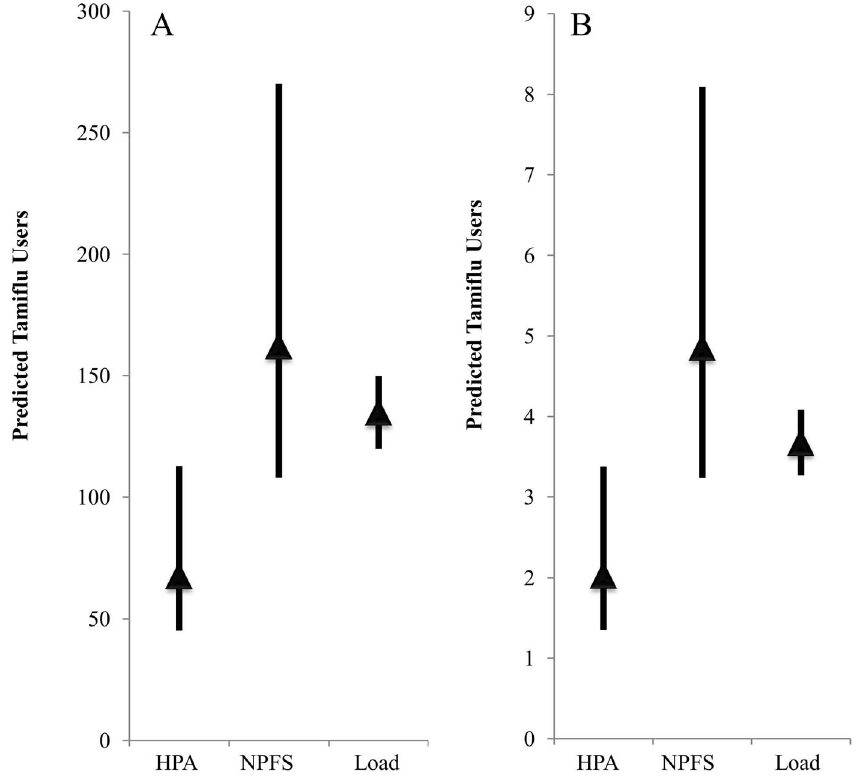
Figure 4. Scenario projections for Tamiflu-consumption. Tamiflu consumption during the 24 hour influent sampling at Oxford (A) and Benson (B) WWTPs based on HPA or NPFS statistics and varying compliance, Tamiflu metabolism, and ILI prescription rates were as detailed in the Materials and Methods. Load represents back-calculated predicted number of Tamiflu users for the 24-h sampling period assuming 80 or 100% OC in the waste stream. The mean of the scenarios is represented by a shaded triangle.